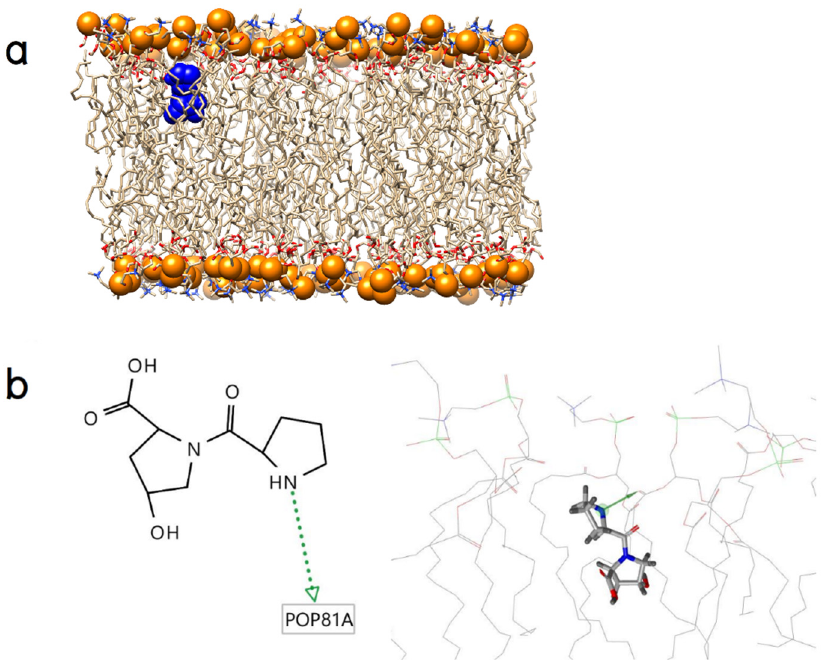
Figure 3. ( a ) An initial position of Pro-Hyp (blue surface) and ( b ) its binding modes (the green arrow represents a hydrogen bond donor).